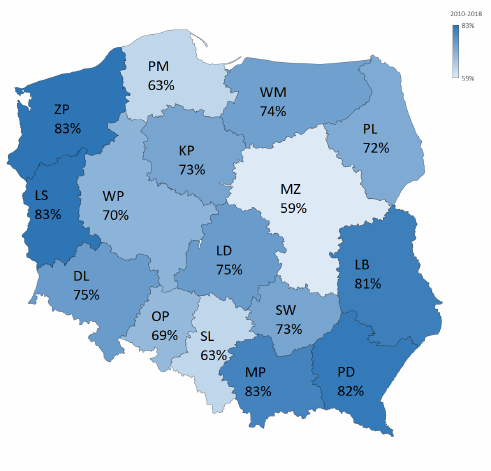
Figure 2: Increase in LGU tax revenue per capita by voivodeship and its increase (%) in